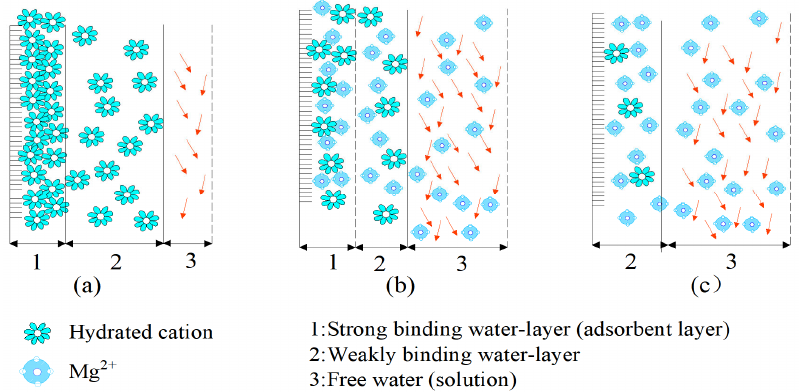
Figure 6. The process of gradual disappearance of a strong binding layer. ( a ) DI water; ( b ) 2% MgSO 4 ; ( c ) 5% MgSO 4